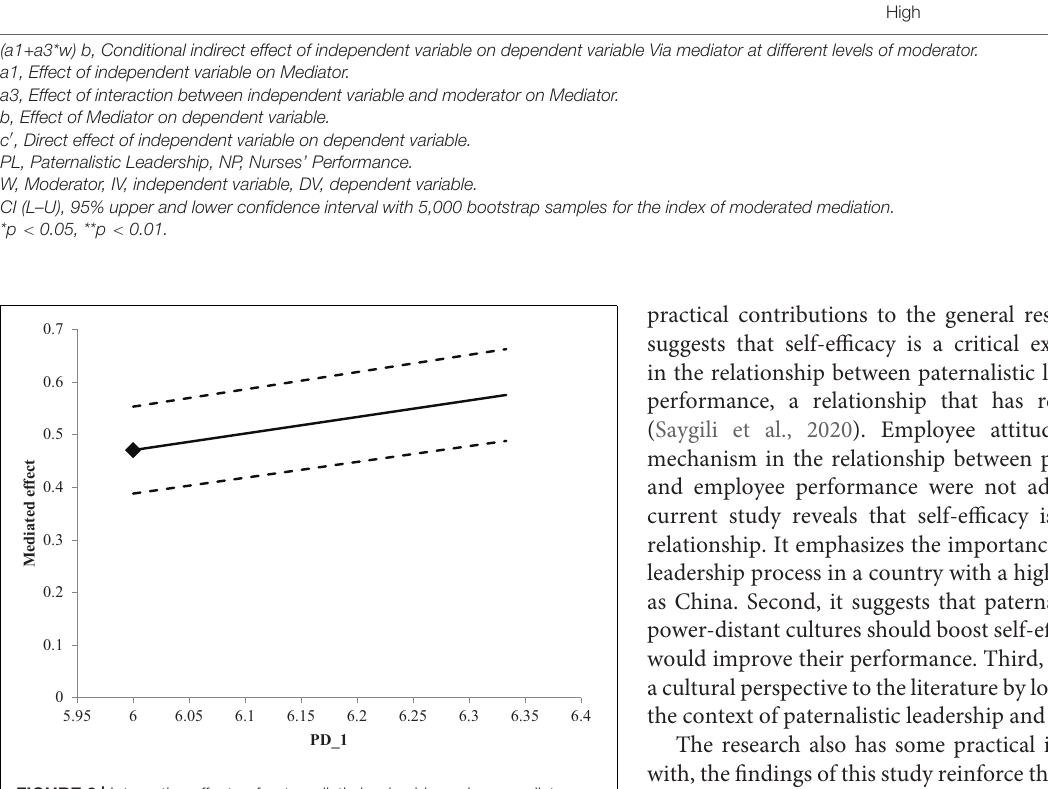
FIGURE 2 | Interactive effects of paternalistic leadership and power distance on